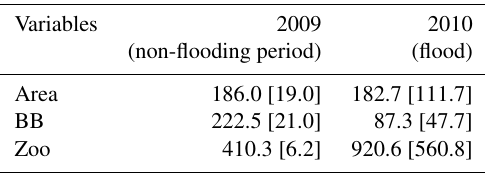
Table 2. Total area ( × 10 3 km 2 ) of the East China Sea (ECS) and Changjiang diluted water (CDW) region (in brackets), as well as bacterial (BB; × 10 6 kgC) and zooplankton (Zoo; × 10 6 kgC) biomass over the euphotic depth integrated for the entire ECS and CDW region (in brackets) during non-flooding (2009) and flooding (2010)